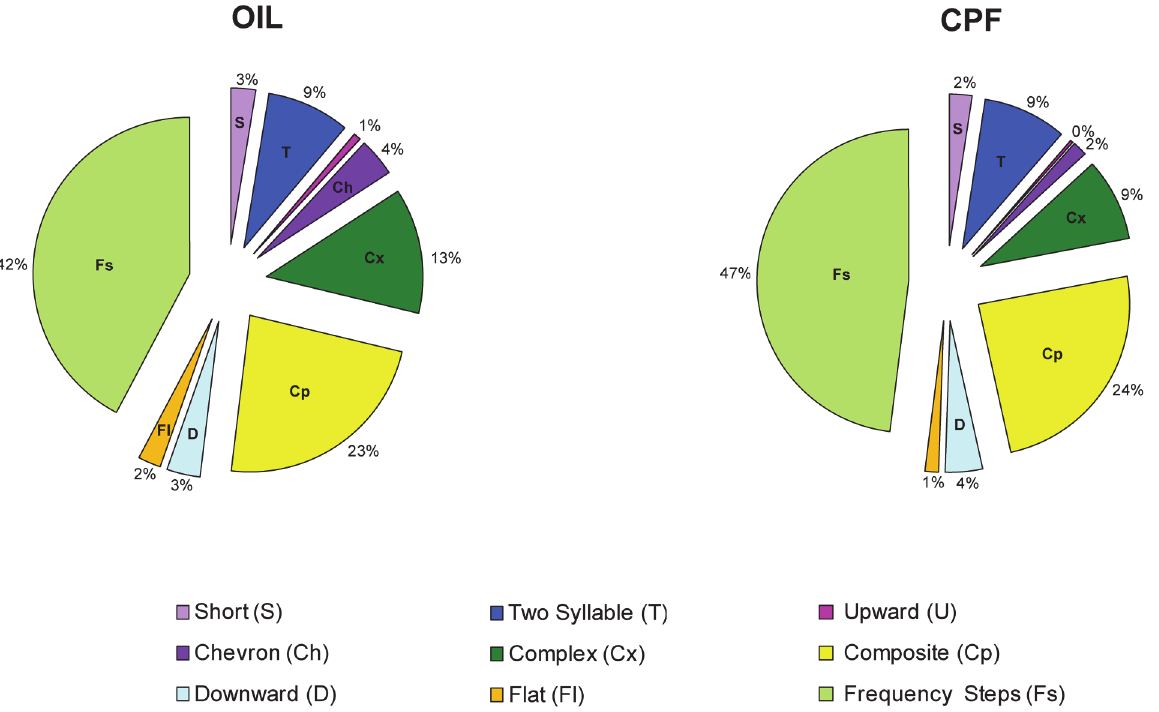
Fig 2. Pie graphs showing the percentages of the different call categories emitted by CPF- and Veh-treated males at postnatal day 8. Percentages were calculated in each treatment group as number of calls in each categories for each subject/total number of calls analyzed in each